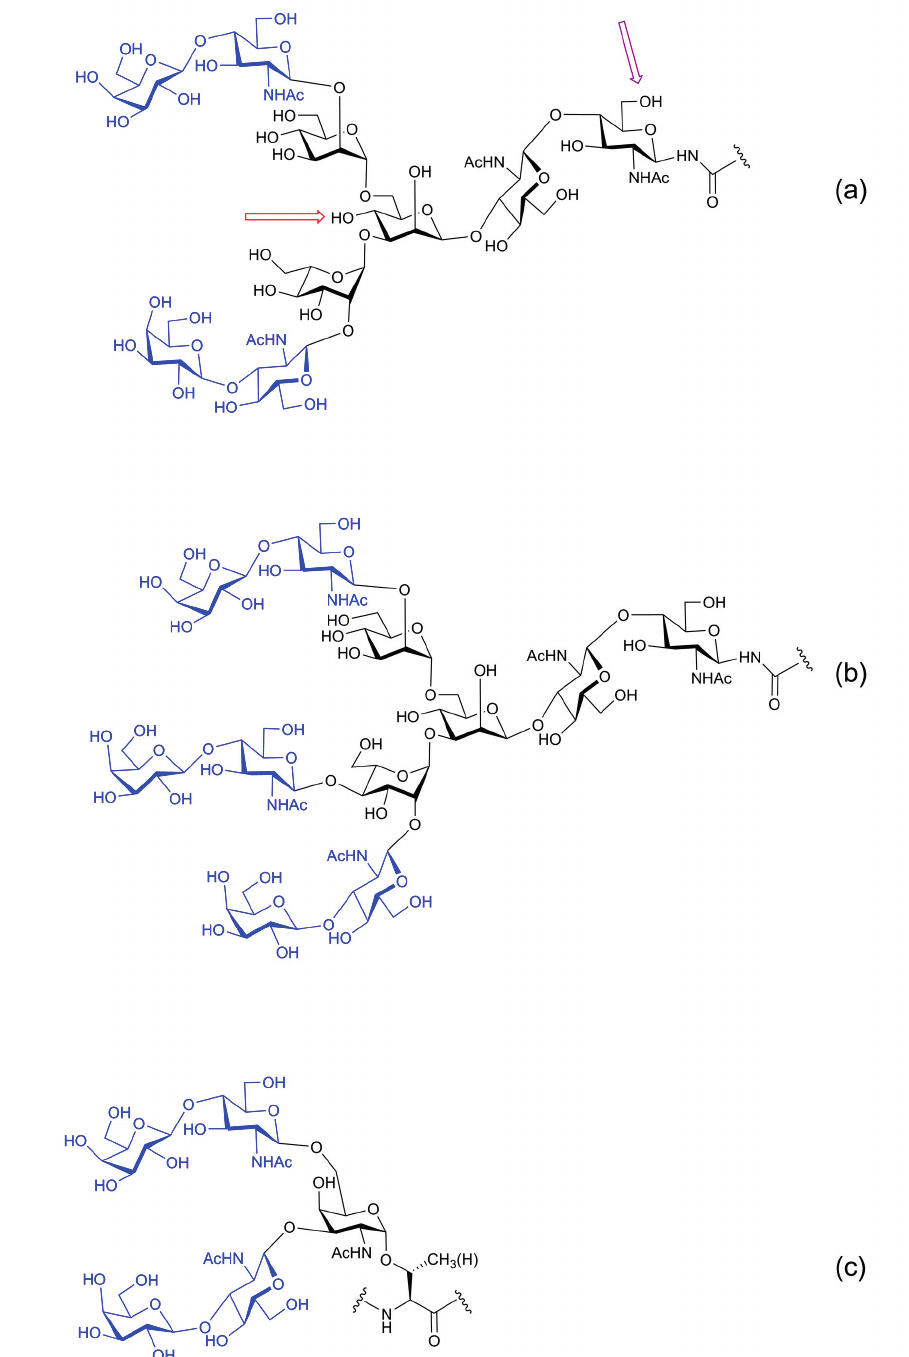
Figure 3. Schematic illustration of physiologically branched glycans. Complex-type N-glycans are constituted by the invariable core pentasaccharide (Man 3 GlcNAc 2 ) and the peripheral region, here with extension of the two antennae ( a ) or introduction of a third branch to form a triantennary N-glycan ( b ). The sites for introduction of core substitutions at the innermost GlcNAc moiety (by α 1,6-fucosylation) or the central Man residue (by β 1,4-conjugation of the bisecting GlcNAc) are labeled by arrows (a). Core branching in mucin-type O-glycans is based on β 1,3-/ β 1,6-extensions from the central GalNAc moiety ( c ). For structures and preparation of synthetic mimetics of the bi- to trivalent N/O-glycans, please see below (Scheme 1, Figures 12–14 and Scheme